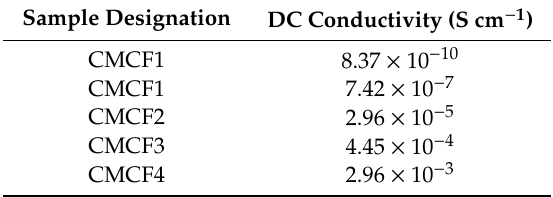
Figure 8. Schematic illustration of the EECs for ( a ) parallel combination of a resistor and capacitor in series with another capacitor and ( b ) series combination of a resistor and capacitor. The resistor is represented by the symbol and the capacitor is represented by .